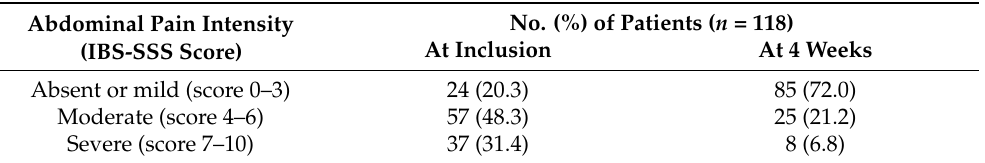
Table 2. Change in abdominal pain intensity scores from inclusion to the end of the 4-week supple- mentation period (IBS-SSS item